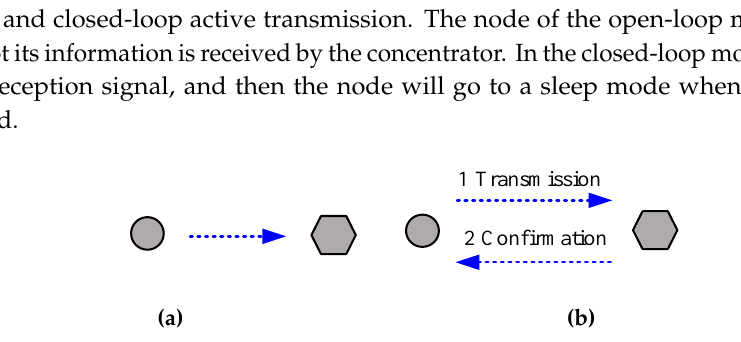
Figure 11. ( a ) The developed concentrator system: (1) controller area network (CAN) output, (2) power supply input, (3) 433 MHz wireless module, (4) registration keys. ( b ) The initial monitoring interface, where the data will come from the concentrator’s CAN output circuit. 3.2. Sending Period of the Node